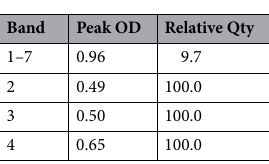
Table 2. Peak density and relative quantity in the desired bands.